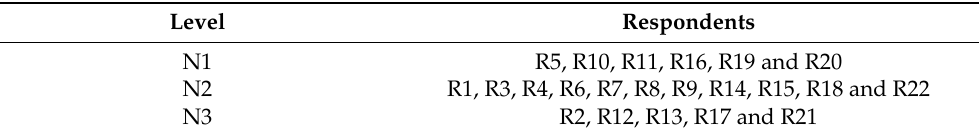
Table 2. Allocation of the respondents based on educational level, experience and knowledge.